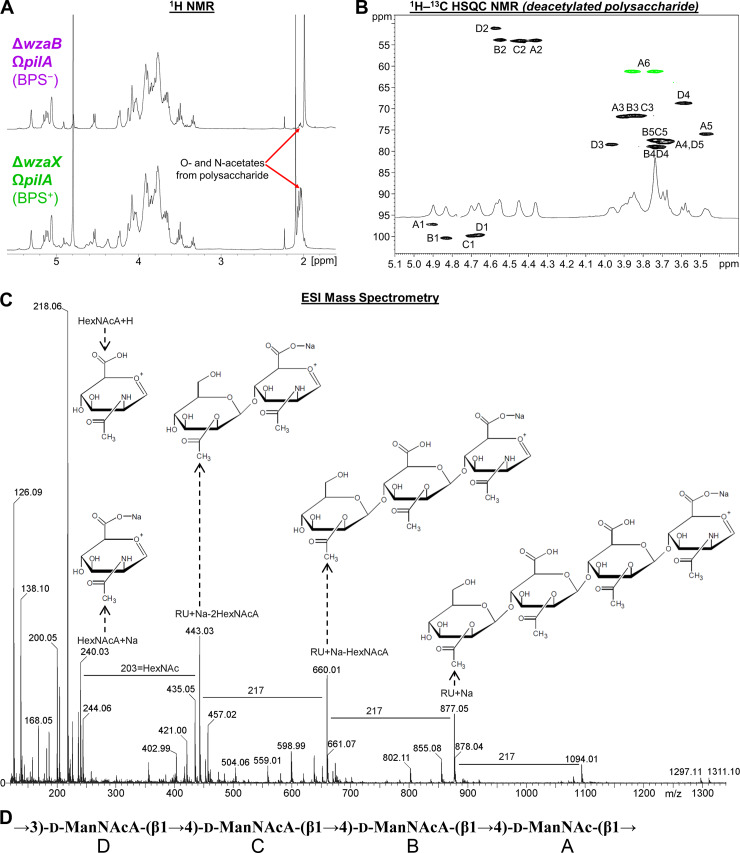
Analysis of BPS composition and structure.(A)
1H NMR spectra of concentrated supernatants from BPS+ ΔwzaX ΩpilA and BPS− ΔwzaB ΩpilA cultures. (B)
1H–13C HSQC spectrum of deacetylated acidic polysaccharide originally isolated from ΔwzaX ΩpilA supernatant. Analysis was performed at 27°C, 500 MHz. Resonance peak colors: black, C–H; green, C–H2. (C) Negative-mode high cone voltage (180 V) ESI-MS of deacetylated acidic polysaccharide from ΔwzaX ΩpilA supernatant. (D) Chemical structure of the BPS polymer tetrasaccharide RU. BPS, biosurfactant polysaccharide; d-ManNAc, N-acetyl-d-mannosamine; d-ManNAcA, N-acetyl-d-mannosaminuronic acid; ESI-MS, electrospray ionization mass spectrometry; HSQC, heteronuclear single quantum correlation; RU, repeating unit.